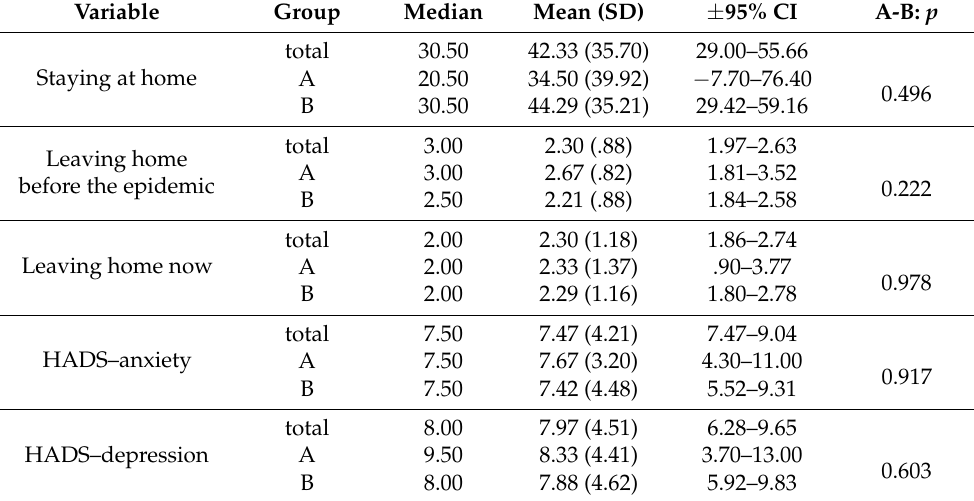
Table 2. Behavior and level of affective disorders—Study